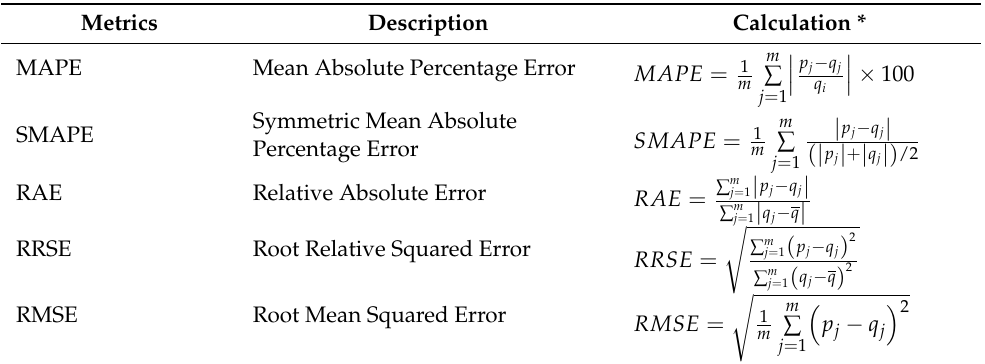
Table 1. Equation of performance